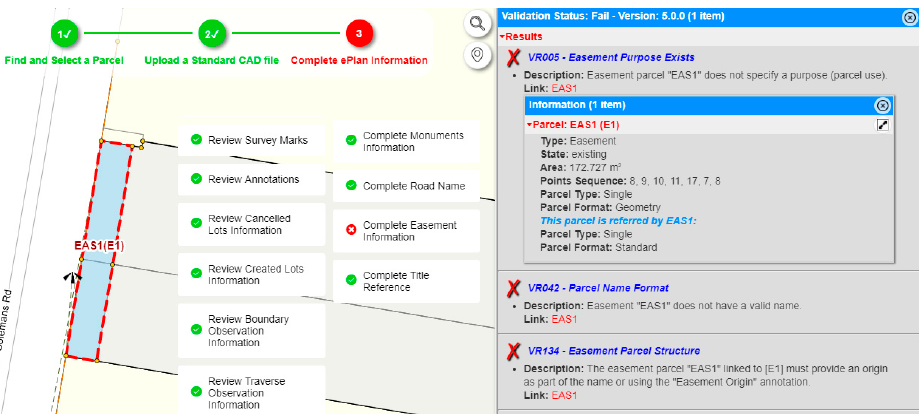
Figure 6. Interactive validation functionality built in the PoC.